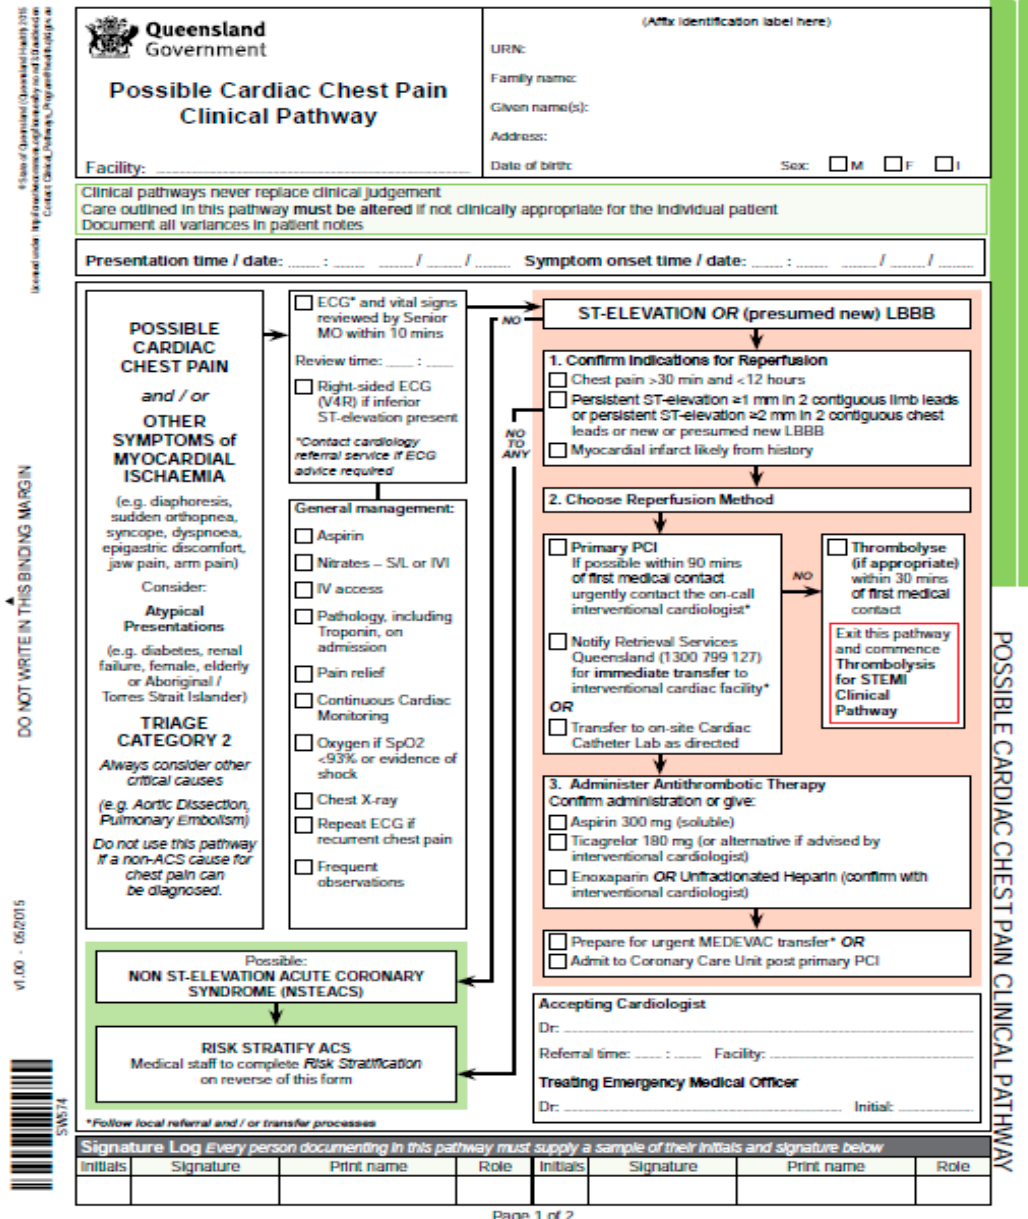
Figure 3. Example of the clinical pathway: “Possible Cardiac Chest Pain Clinical Pathway”. Source: State of Queensland